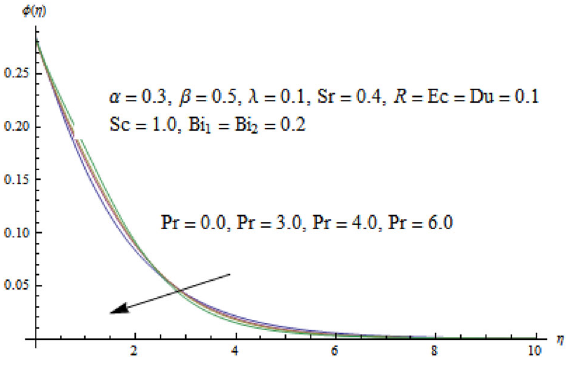
Fig. 22 Impact of Pr on φ(η)